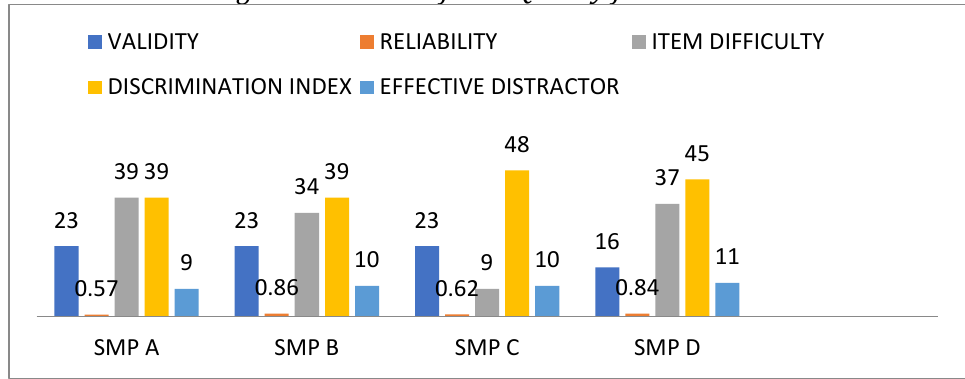
Figure 1. Results of Test Quality from Each School